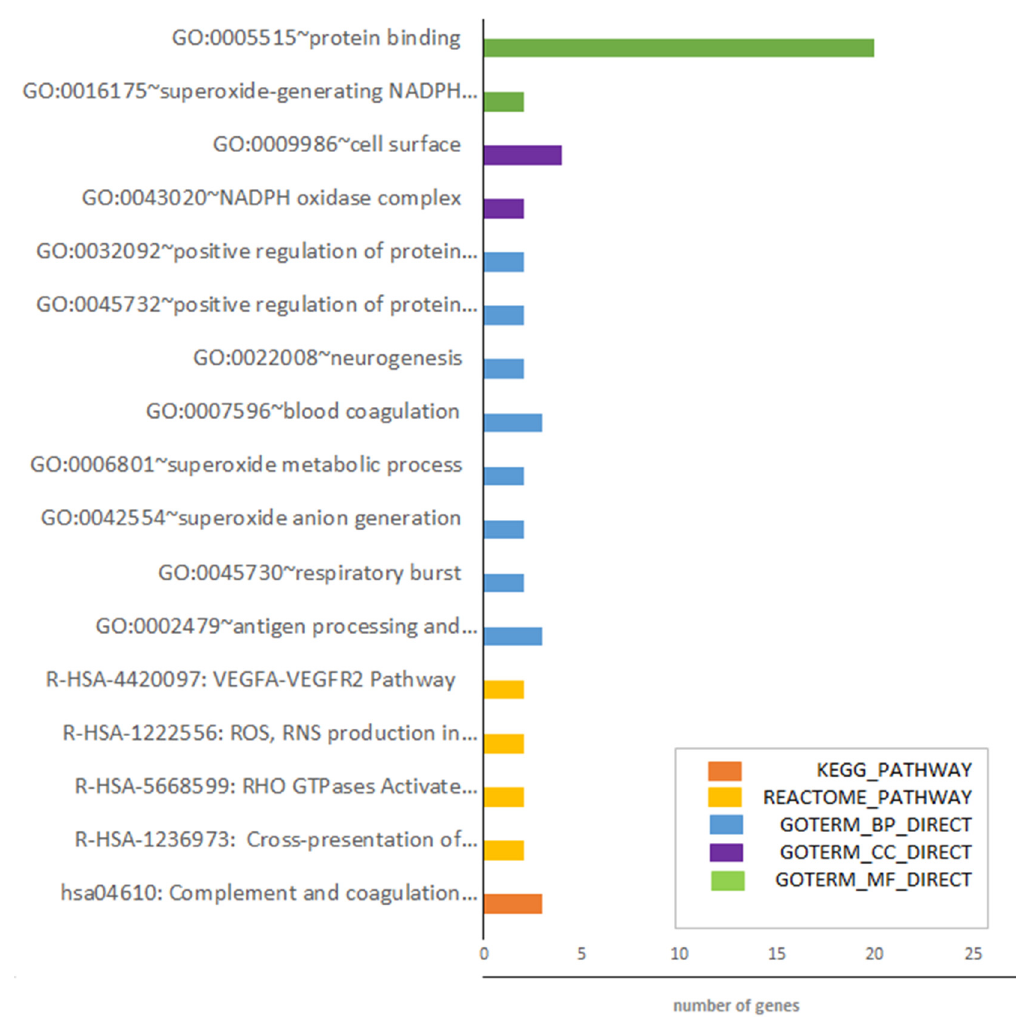
Figure 3. Functional annotation of identified DEGs in rapeseed oil vs. beef tallow comparison.